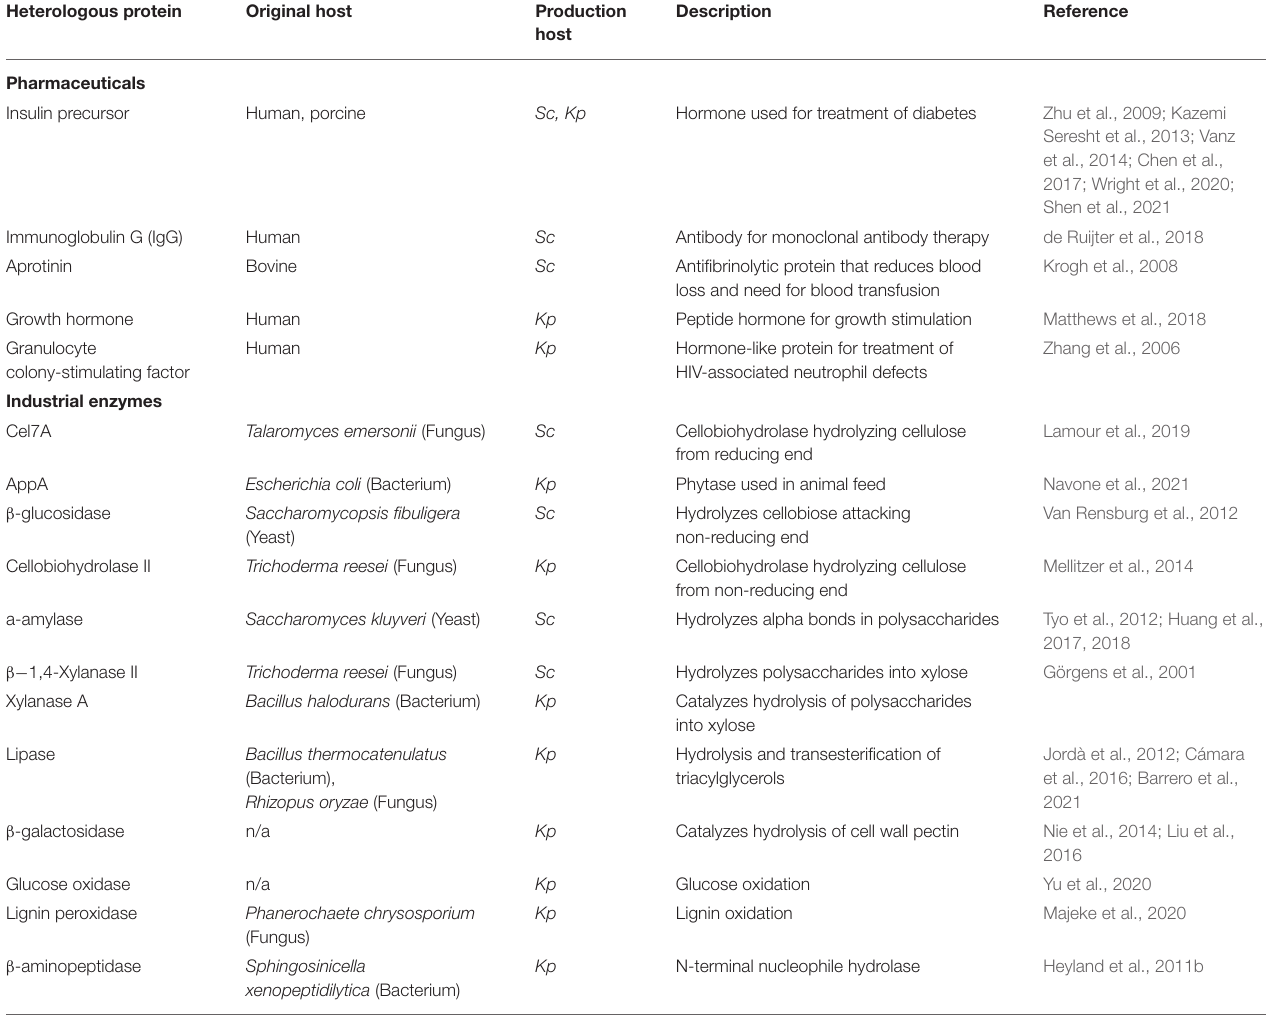
TABLE 1 | Examples of heterologous proteins produced in Saccharomyces cerevisiae ( Sc ) and Komagataella phaffii ( Kp